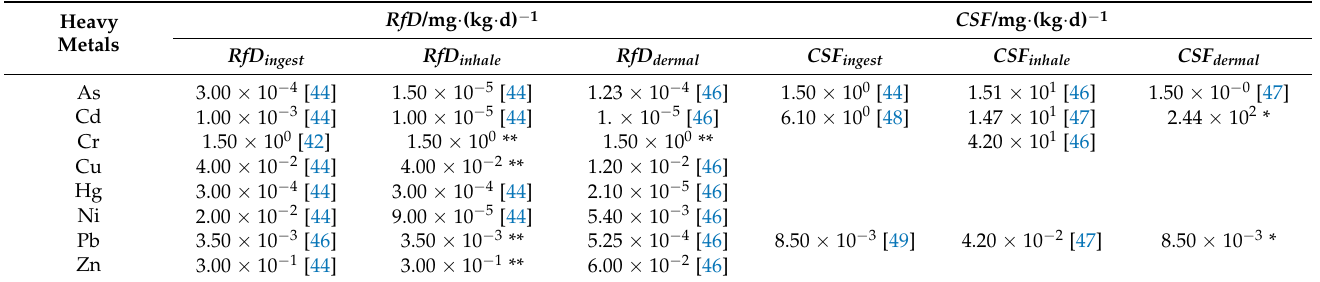
Table 3. Reference dose ( RfD ) and carcinogenic slope factor ( CSF ) of heavy metals for three exposure